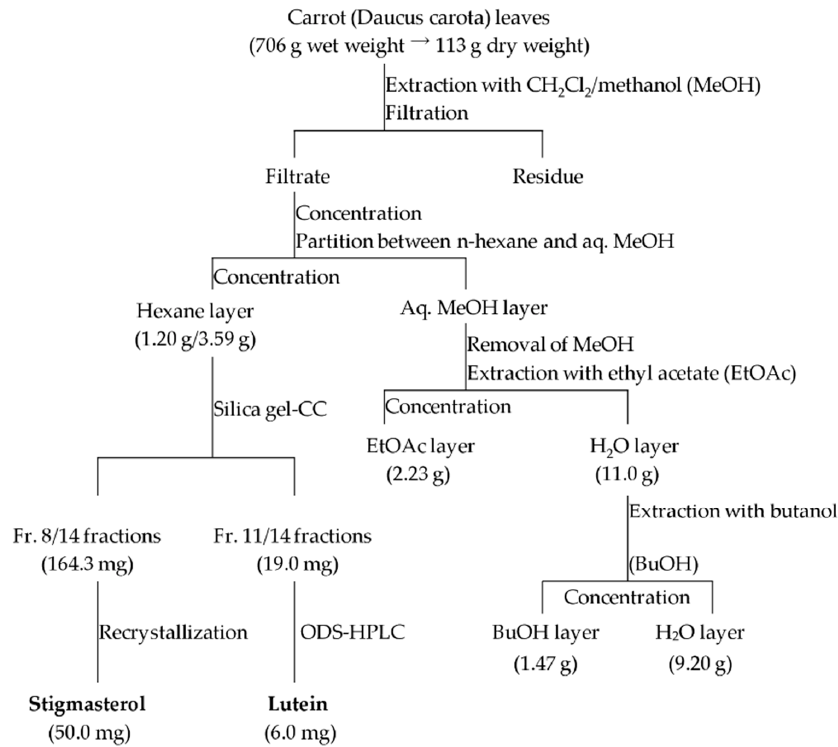
Figure 2. Isolation procedure of active substances from carrot leaves. Each fraction was tested for induction activity of α -1,3-glucan on the surface in Colletotrichum fioriniae .